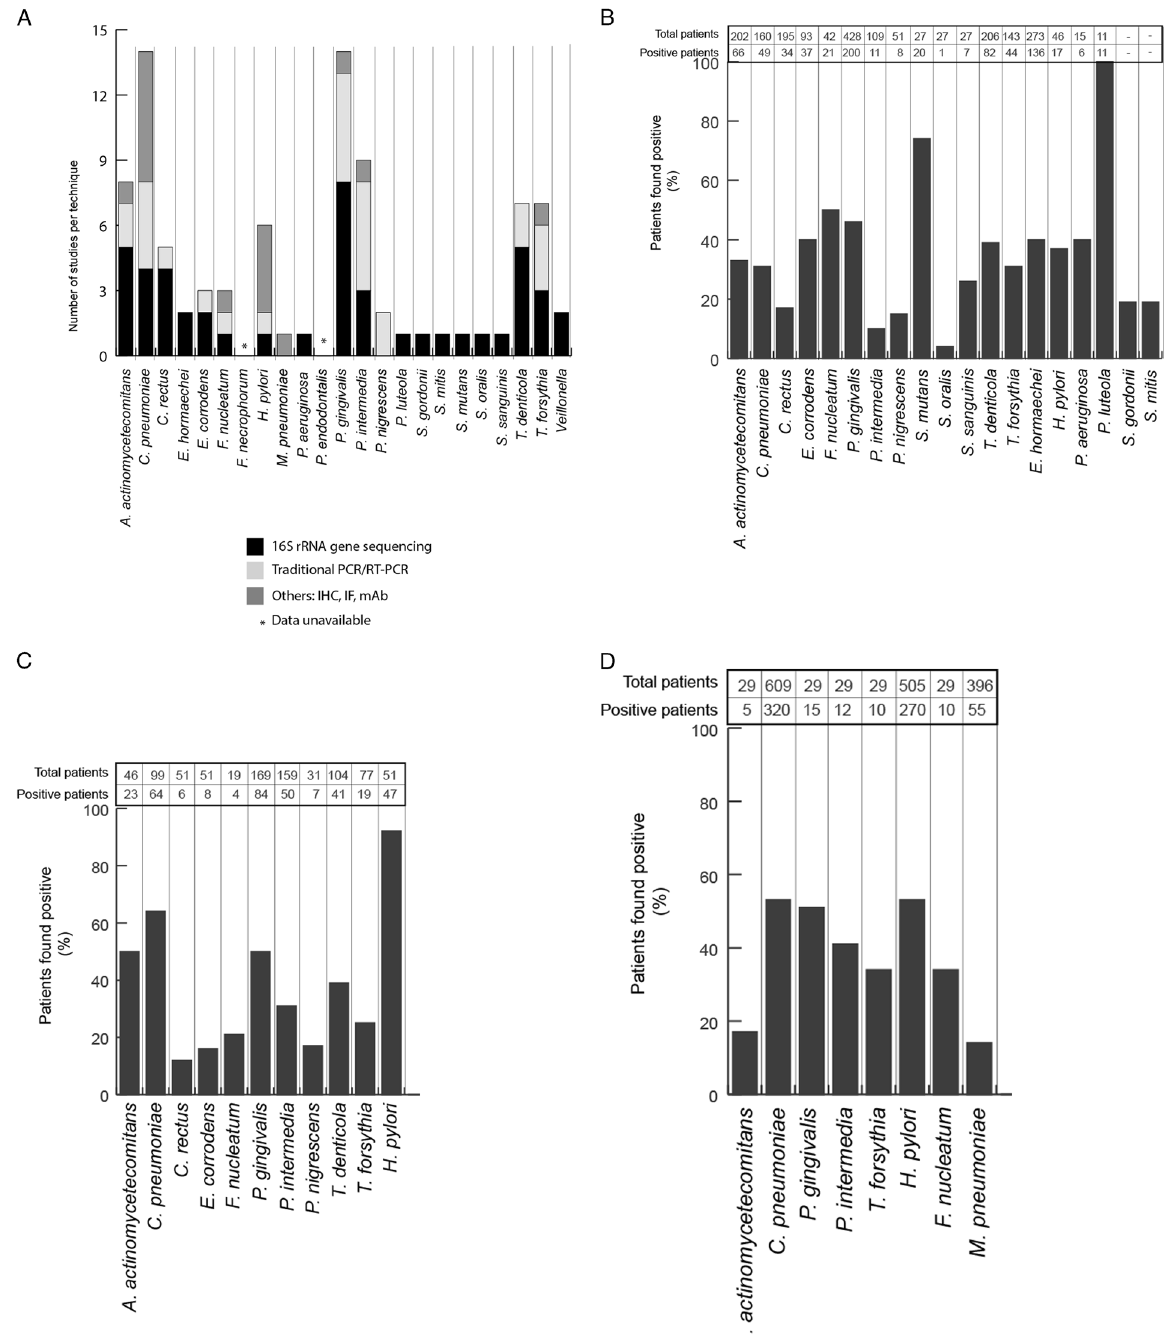
Fig. 2 a Graphical representation of the techniques used to identify the atherosclerotic plaque-associated bacteria in CAD patients. Y -axis represents the number of studies reporting the presence of bacteria in the plaque samples, while X -axis depicts the corresponding bacteria. The cohort of 23 commensal bacteria is dominated by gram-negative bacteria with the exception of Streptococcus sp. , which are gram-positive. Of these 23 atherosclerotic plaque-associated bacteria, A. actinomycetemcomitans , C. rectus , E. corrodens , E. hormaechei , S. gordonii , S. mitis , S. mutans , S. oralis , S. sanguinis , H. pylori , and P. aeruginosa are facultative anaerobes, while C. pneumoniae , F. necrophorum , F. nucleatum , M. pneumoniae , P. endodontalis , P. gingivalis , P. intermedia , P. nigrescens , T. denticola , and T. forsythia are obligatory anaerobes. There are two exceptions in P. luteola (aerobe) and Veillonella (anaerobe). IF immuno fl uorescence, IHC immunohistochemistry, mAb monoclonal antibodies. b Atherosclerotic plaque-associated bacteria identi fi ed using 16S rRNA technique. X -axis represents the % of patients positive for the bacteria identi fi ed using 16S rRNA gene sequencing, while Y -axis represents the corresponding bacteria. Total number of study subjects vs. positive patients is mentioned on the top of graph. c Atherosclerotic plaque-associated bacteria identi fi ed using traditional PCR techniques. X -axis represents the % of patients positive for the bacteria identi fi ed using traditional PCR techniques, while Y -axis represents the corresponding bacteria. Total number of study subjects vs. positive patients is mentioned on the top of graph. d Atherosclerotic plaque- associated bacteria identi fi ed using immuno fl uorescence, immuno-histochemistry, and antibody screening methods. X -axis represents the % of patients positive for the bacteria identi fi ed using multiple techniques, while Y -axis represents the corresponding bacteria. Total number